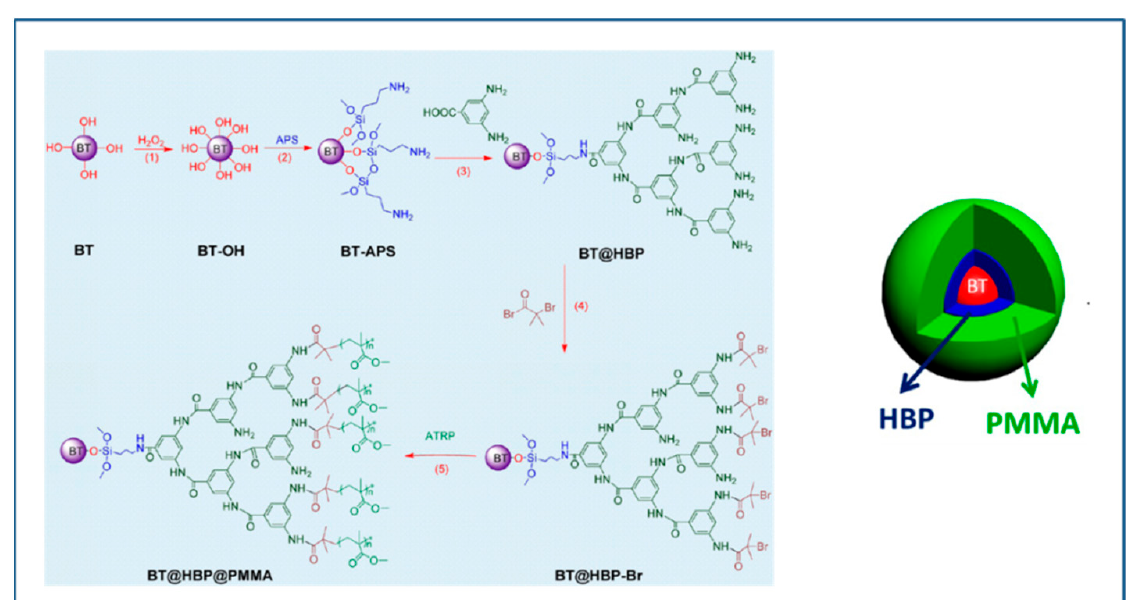
Figure 9. Schematic illustrating the preparation of PMMA@HBP@BT. Reproduced with permission from Ref. [125]. The attachment of phosphonic acid-based ATRP initiator on BaTiO 3 nanoparticles followed by growth of PMMA on BaTiO 3 nanoparticles via activated regenerated by electron transfer (AGRET) ATRP approach (Figure 10) was reported to compare and contrast the dielectric performance of single- and multi-component nanocomposites [27]. A comparison of PMMA@BaTiO 3 one component nanocomposite and phosphonic acid- modified BaTiO 3 mixed PMMA two component nanocomposite, at same loading of 16 vol%, showed that the two-component nanocomposite has energy density of ~1.9 J/cm 3 at 256 V/ µ m while one component nanocomposite has energy density of ~2 J/cm 3 at a 25% lower field strength (220 V/ µ m) which implies a 2-fold enhancement in energy density due to the covalent attachment of PMMA to BaTiO 3 nanoparticles.